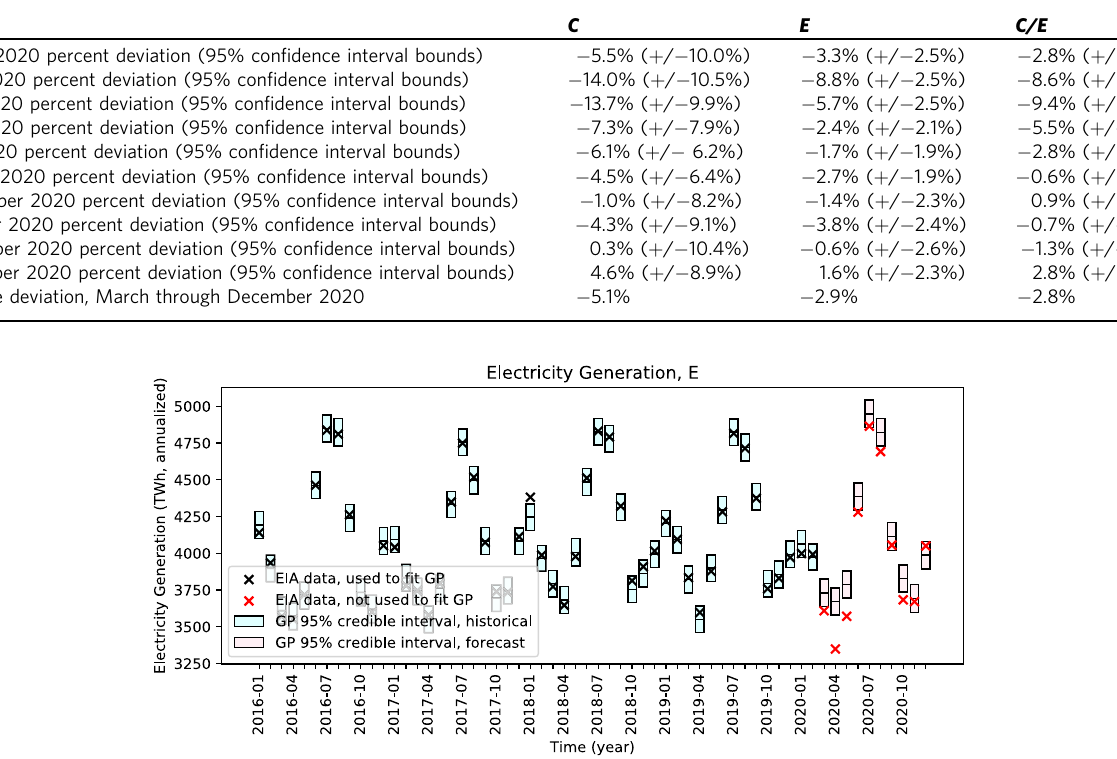
Table 1 Percent deviations between observed values and counterfactual estimates and 95% con fi dence interval bounds for CO 2 emissions ( C ), electricity generation ( E ), and carbon intensity of electricity supply ( C/E ) in the U.S. power sector.